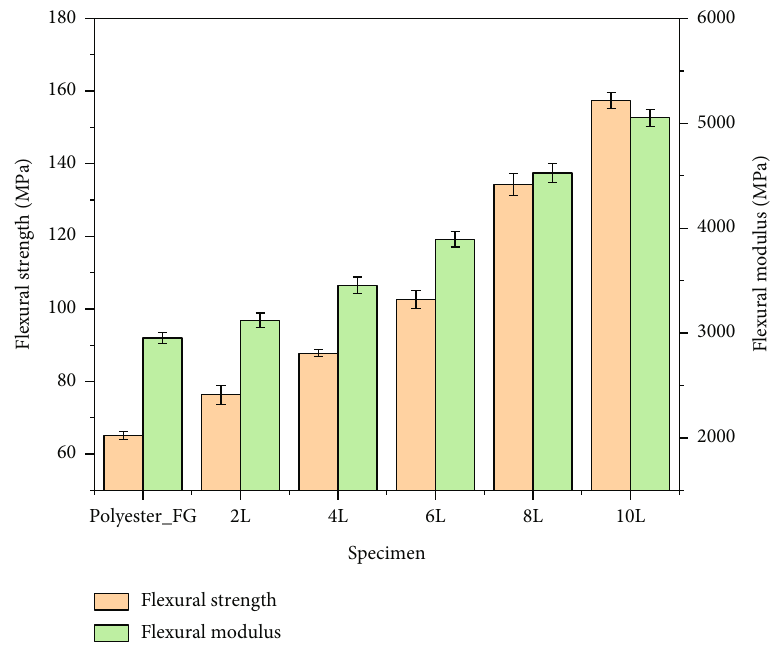
Figure 14: Sandwich-structured composite ’ s fl exural strength and fl exural modulus.